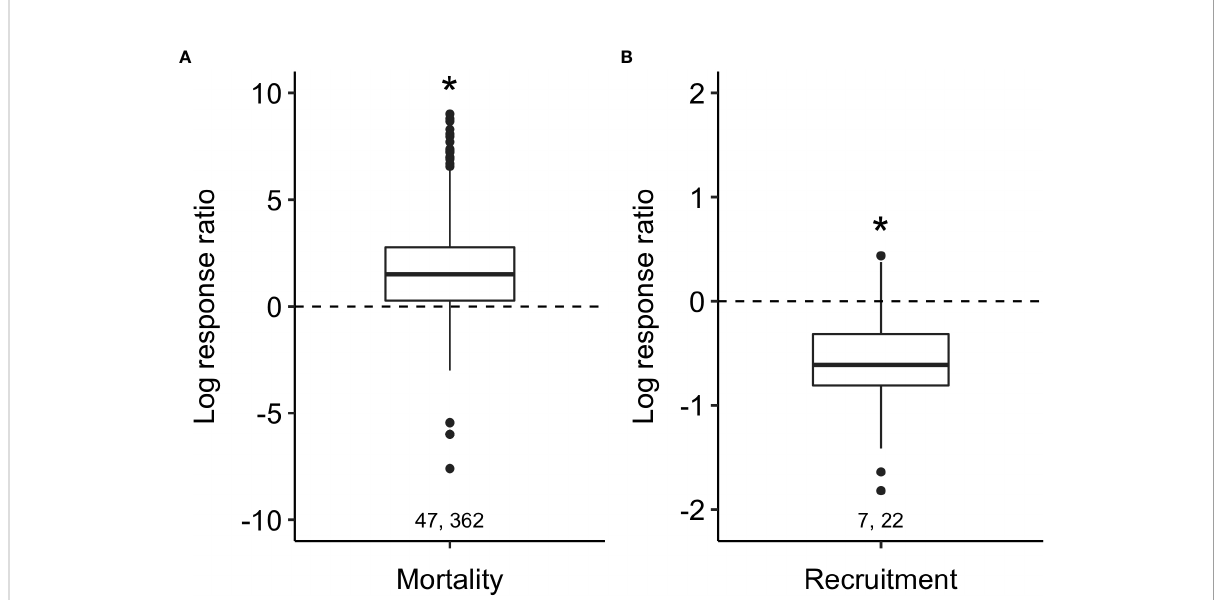
FIGURE 2 Predators increased oyster mortality (A) and decreased recruitment (B) across the entire meta-dataset. Boxplots show median (bold lines) effect sizes and interquartile ranges (boxes) with outliers greater than 1.5 × IQR (whiskers). Pairs of numbers represent the number of published papers (left) and the number of independent experiments (right). The dotted line at zero is the effect size expected if there is no effect of predators and asterisks show where means differ from zero ( p < 0.01). Note difference in y-axis scale between the two panels.